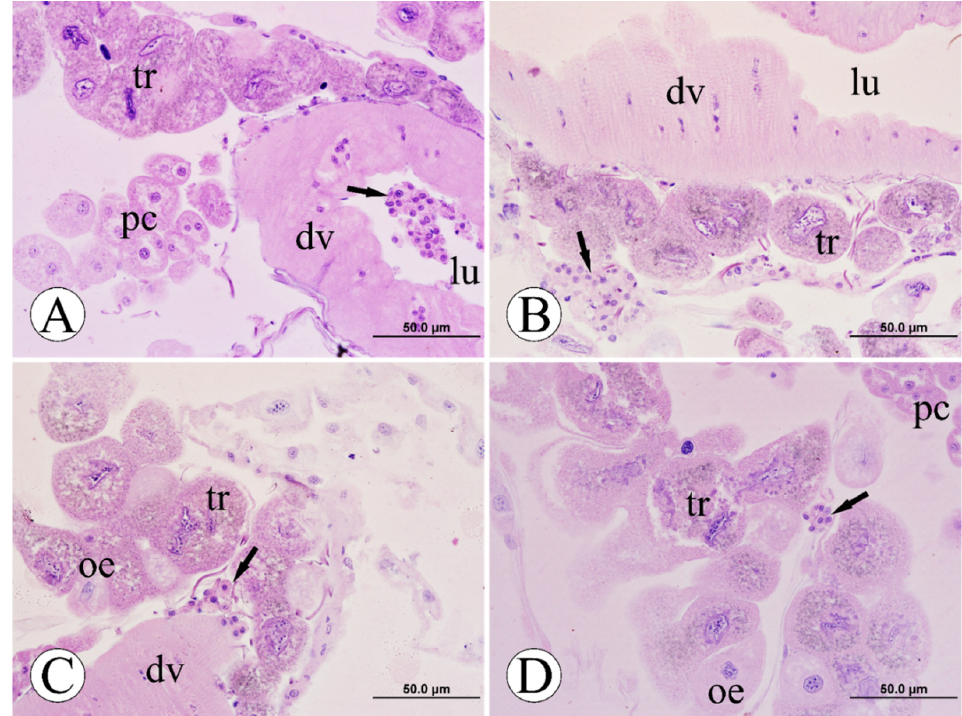
Figure 6. Hemocytes of foragers of Africanized honey bee after five days of oral exposure to fungicide pyraclostrobin. ( A – D ): pyraclostrobin 0.125 ng/µL (125 ppb)-FG1. Legend: black arrow = agglomeration of immune system cells-hemocytes, dv = dorsal vessel, lu = lumen, oe = oenocytes, pc = pericardial cells, tr = trophocytes. Histological sections stained with hematoxylin and eosin. N = 5 individuals.